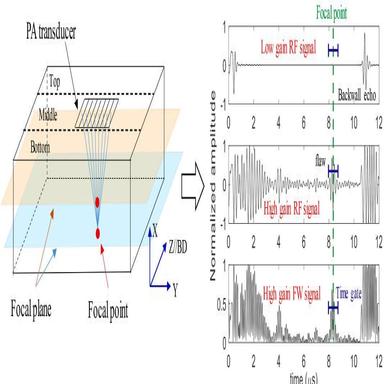
Schematic illustration of the PA backscattering method for inhomogeneity characterization.